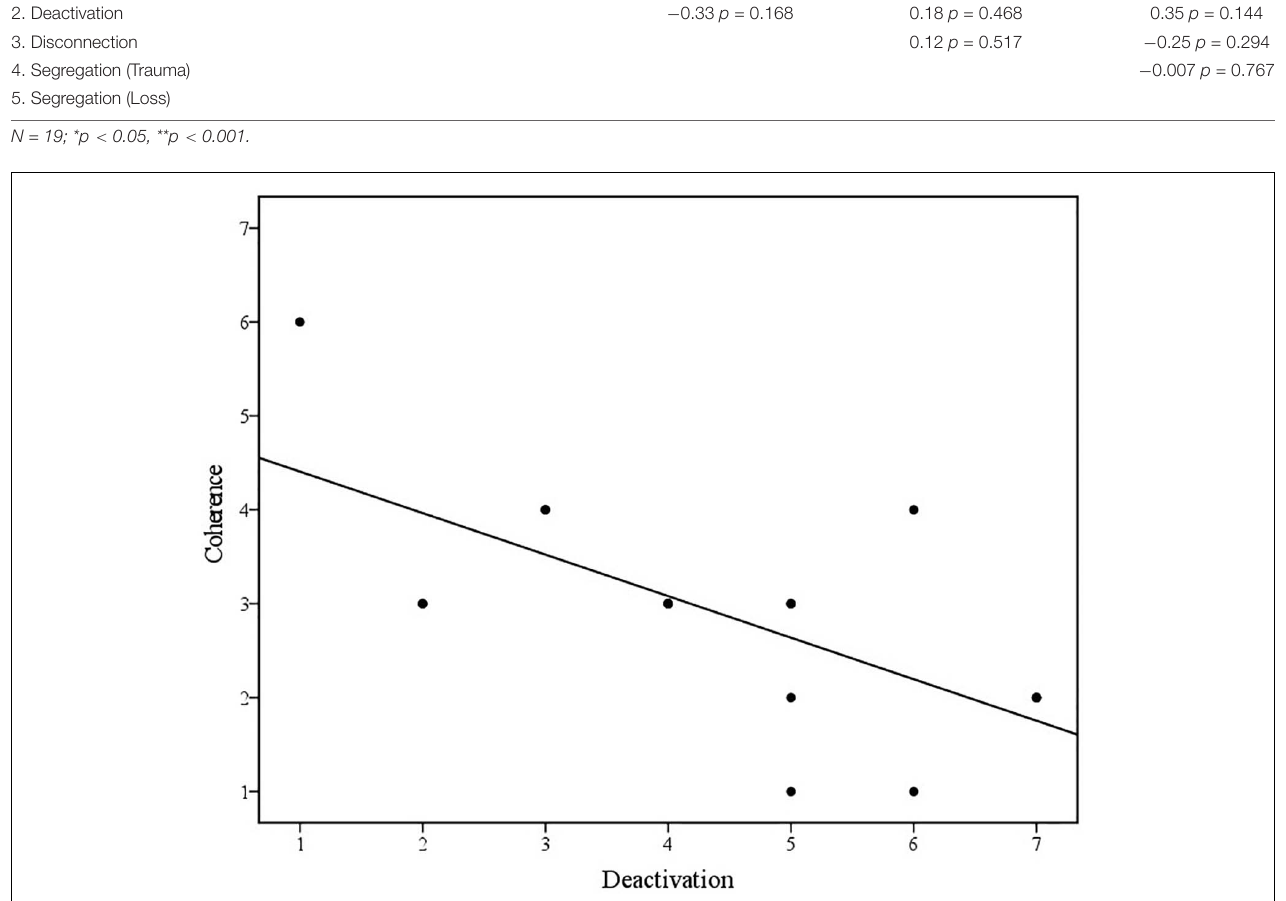
FIGURE 2 | Scatterplot and line of best fit (linear) illustrating the association between Coherence of family discourse and Deactivation ( N = 19) (Linear equation: y = 4.85–0.44 × ; R 2 = 0.45).